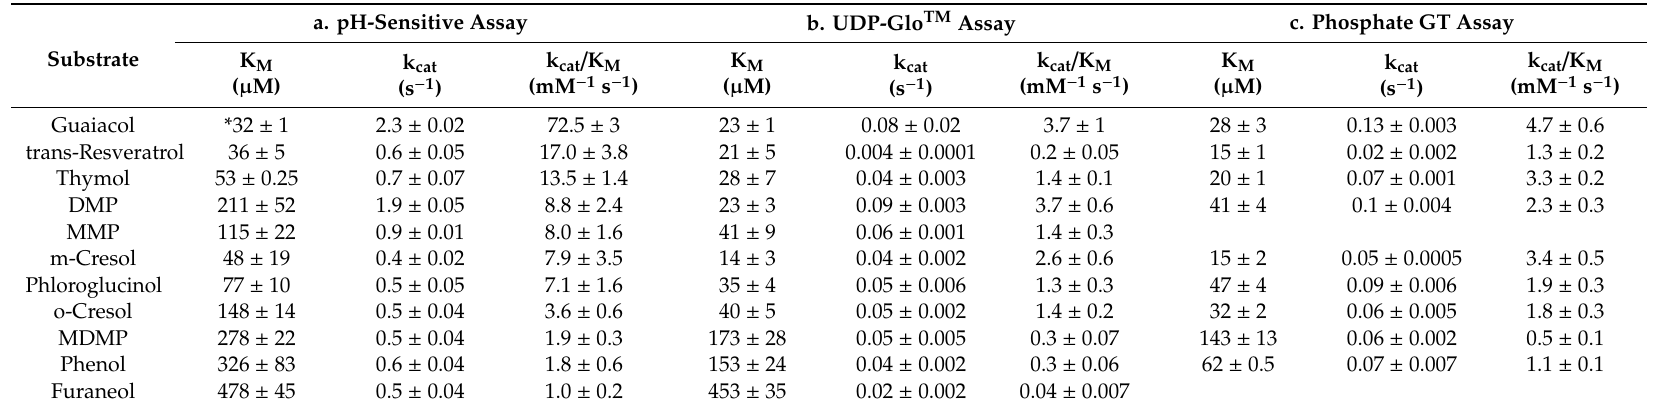
Table 2. Comparison of kinetic values of purified UGT72B27 enzyme obtained via three di ff erent detection methods. ( a ) pH-sensitive assay, data taken from [35], obtained by single measurements, ( b ) UDP-Glo TM assay, measured in 384-well plate, and ( c ) phosphate glycosyltransferase assay, measured in 96-well plate. Substrate concentrations were varied from 10–3000 µ M. Guaiacol: 2-Methoxyphenol, DMP: 2,6-Dimethoxyphenol, MMP: 2-Methoxy-4-methylphenol,